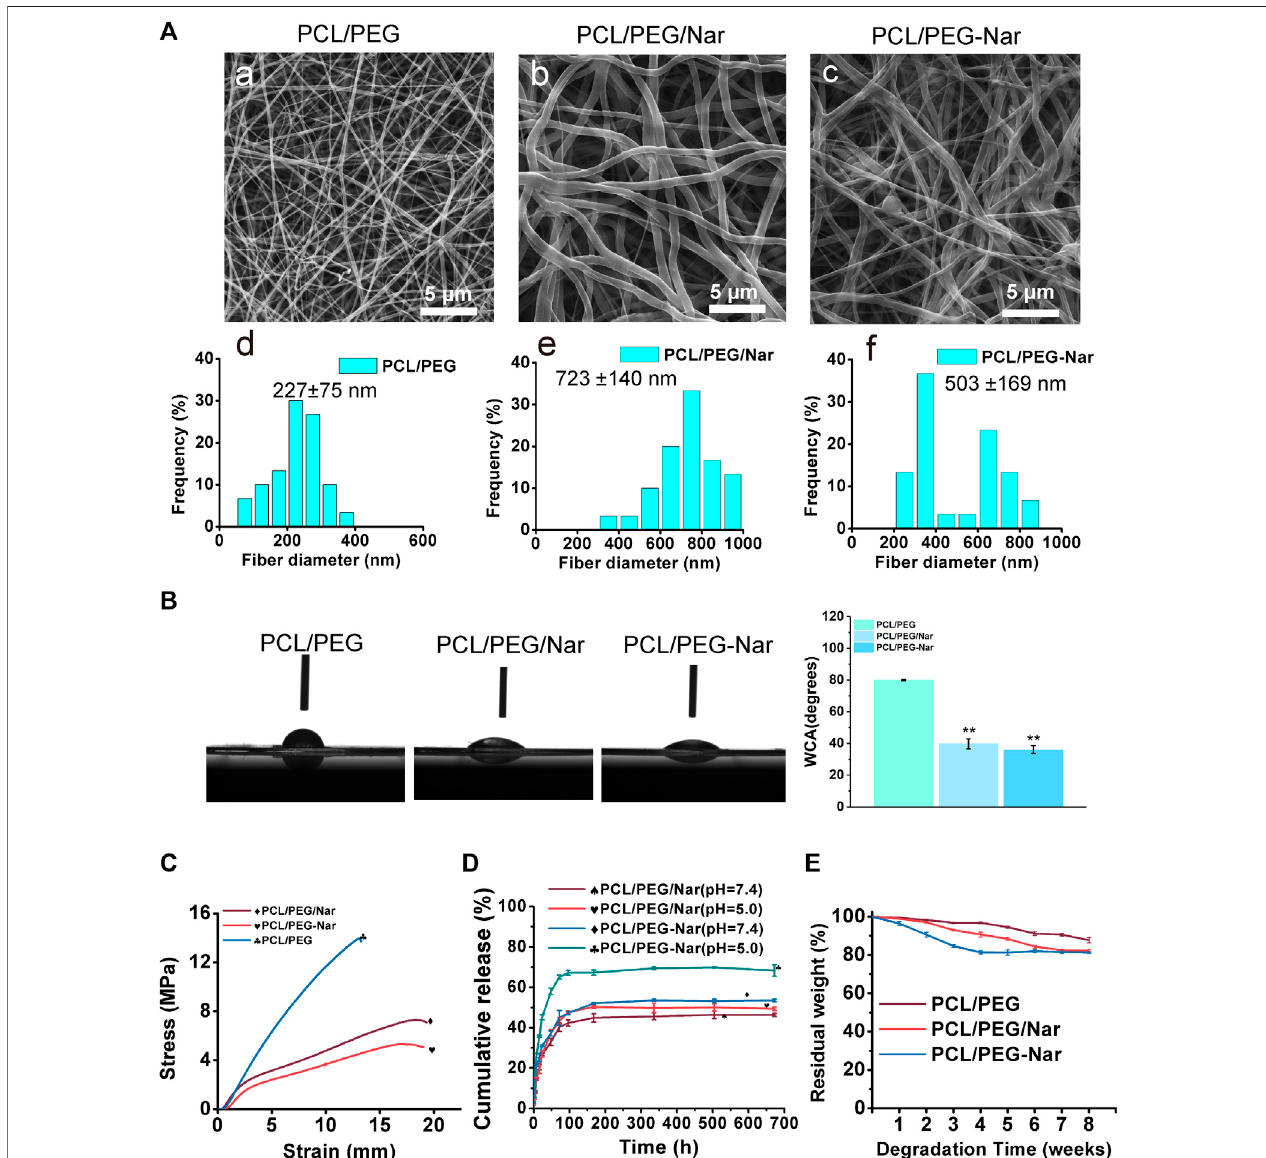
FIGURE 3 | Characterizations of PCL/PEG, PCL/PEG/Nar, and PCL/PEG-Nar. (A) Scanning electron micrographs and diameter distribution of PCL/PEG (a,d) , PCL/PEG/Nar (b,e) ,andPCL/PEG-Nar (c,f) . (B) WatercontactangleofPCL/PEG,PCL/PEG/Nar,andPCL/PEG-Nar.*indicates p < 0.05,and**indicates p < 0.01. (C) Mechanical properties of PCL/PEG, PCL/PEG/Nar, and PCL/PEG-Nar. (D) Drug-releasing behavior ofPCL/PEG/Nar and PCL/PEG-Nar. (E) Degradation rates of PCL/ PEG, PCL/PEG/Nar, and PCL/PEG-Nar in PBS (pH 7.4) at 37 ° C.